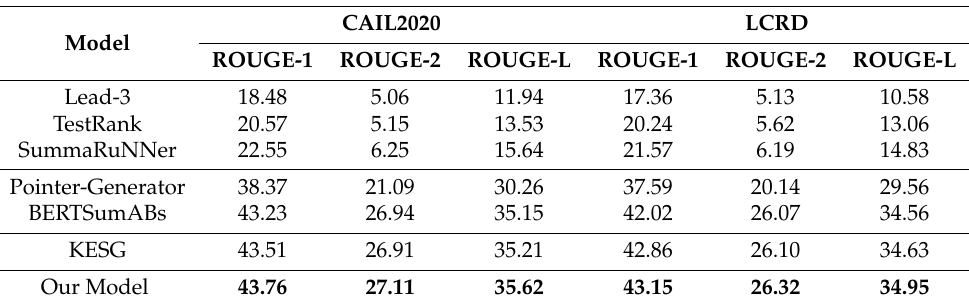
Table 1. Comparison results on two datasets. We compared the performance of our model with three types of text-summarization